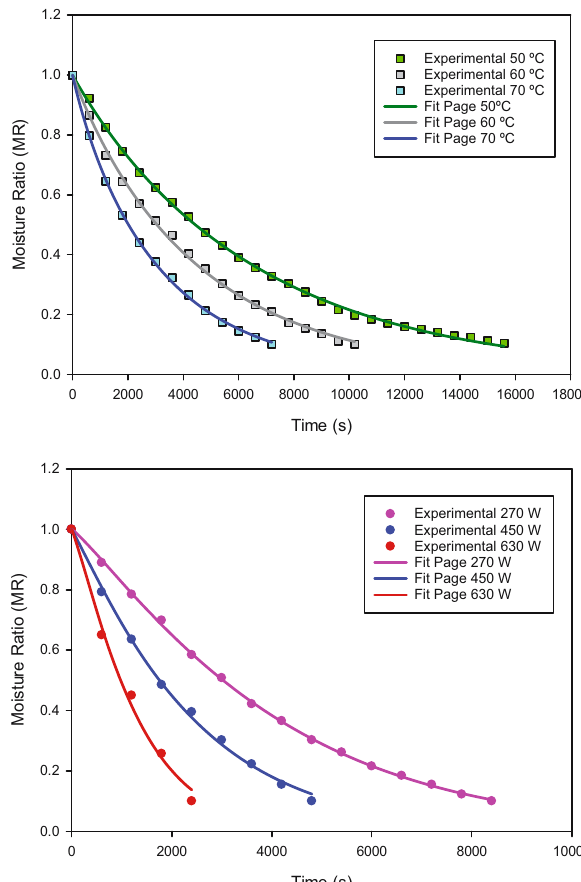
Figure 3: Experimental curves for moisture ratio versus time and fi tting with model Page for convective drying ( top ) and for micro - wave drying ( bottom ) of pomegranate arils.